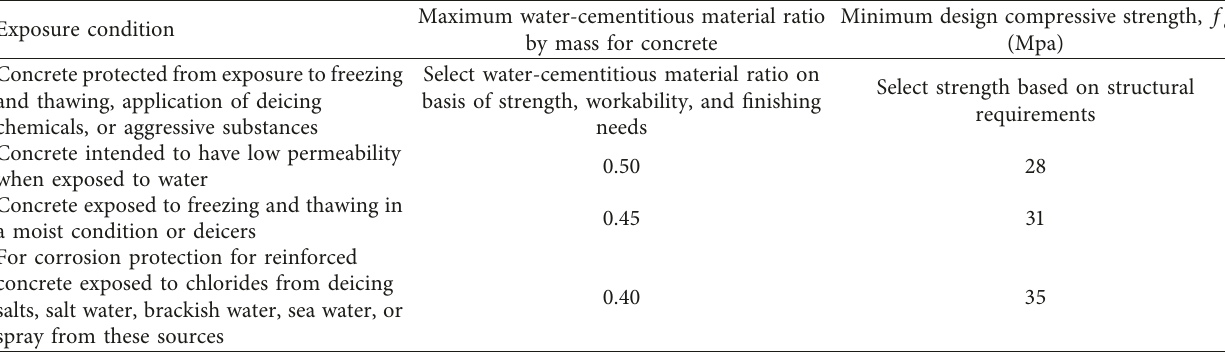
Table 6: Maximum water-cementitious material ratios and minimum design strengths for various exposure conditions “Table 6 is